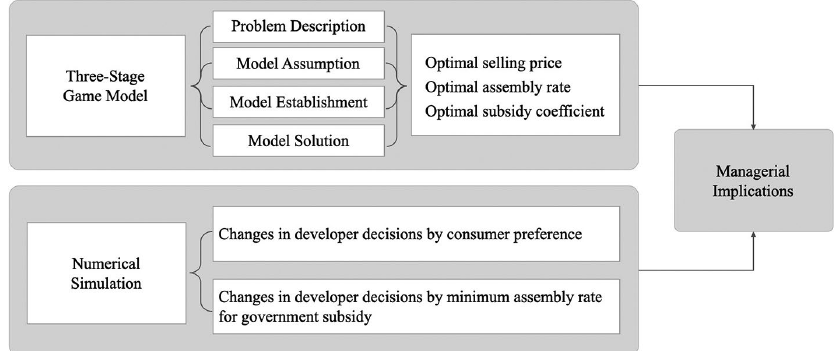
Figure 1. Research